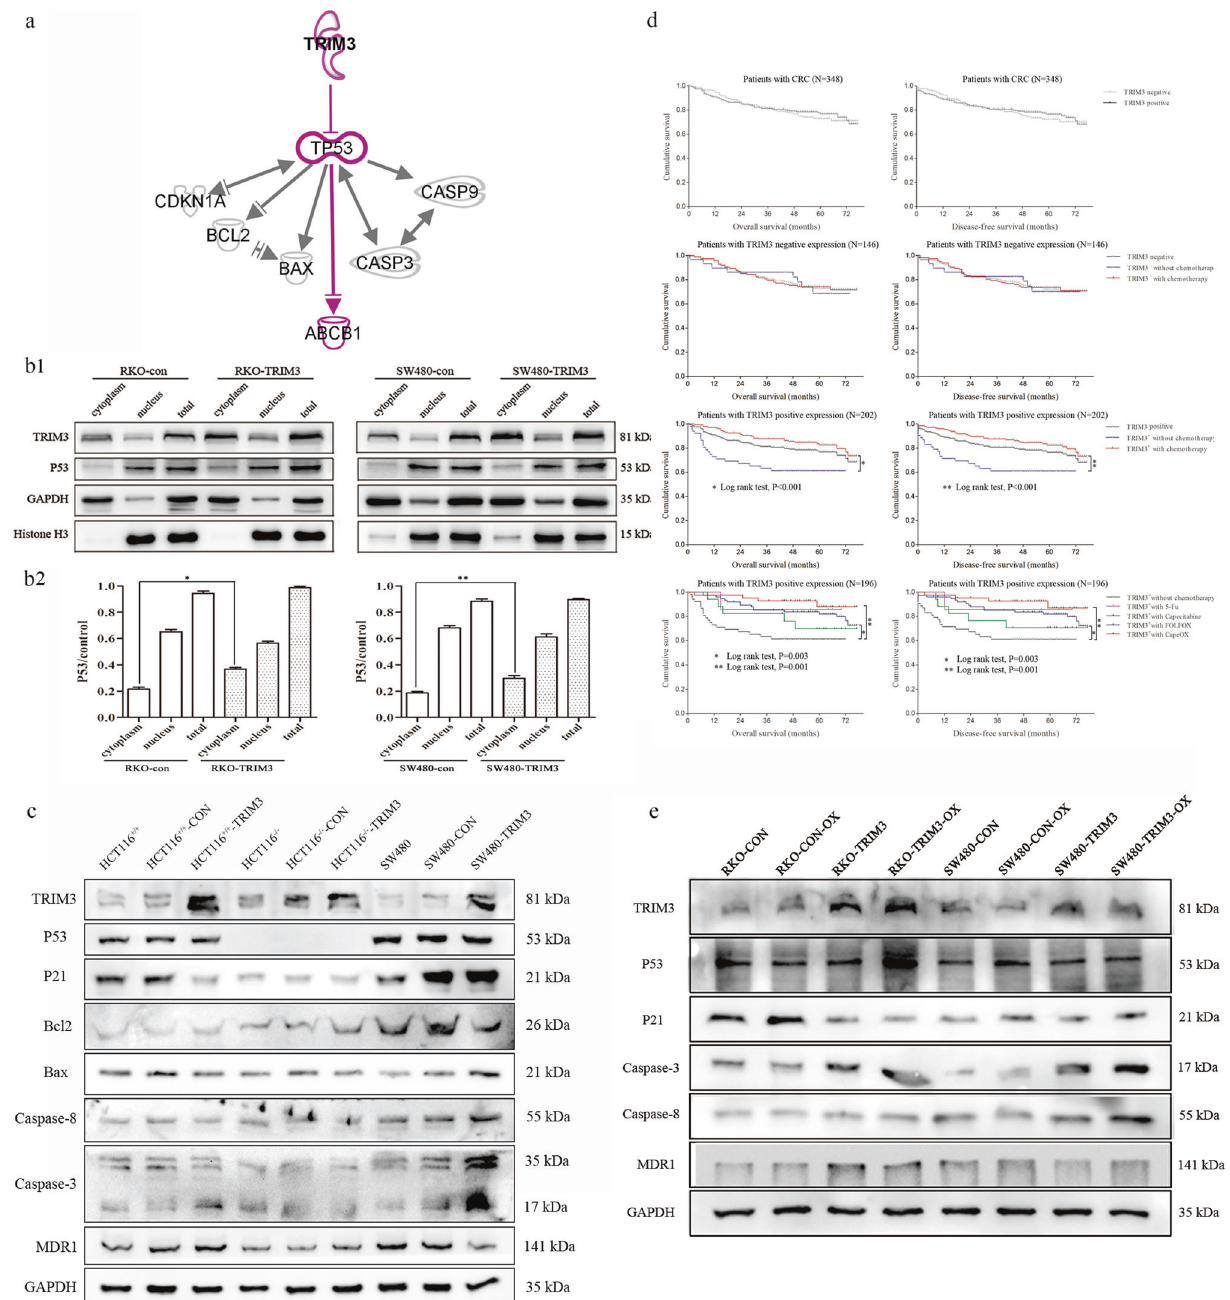
overexpression; b2 The quanti fi cation of p53 determined by densitometry of protein bands. GAPDH was the loading control in the nuclei and total; Histone H3 was the loading control in the cytoplasm; c The expression of downstream pathway of p53 after TRIM3 overexpression in